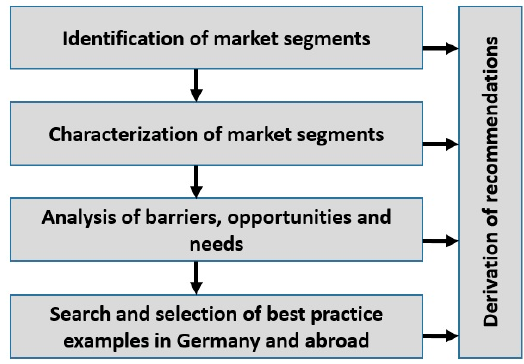
Figure 3. Methodical approach.